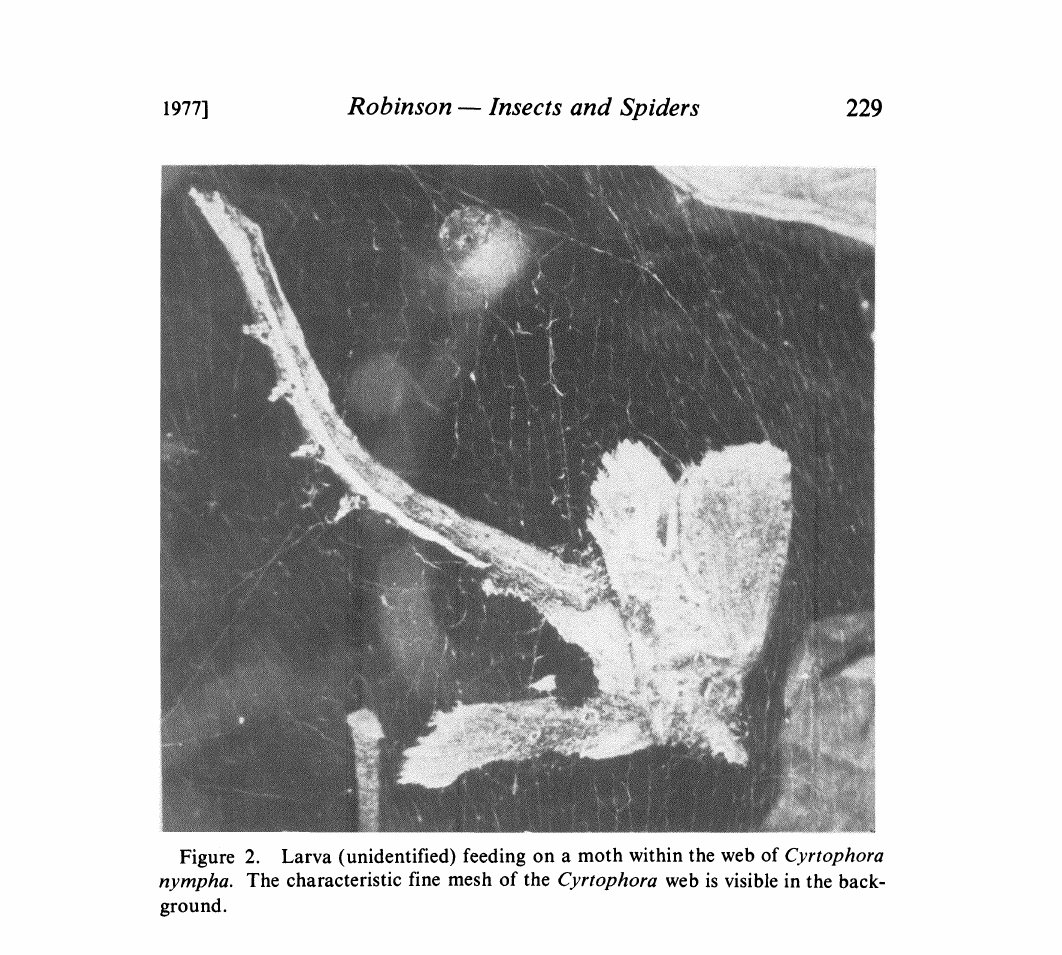
Figure 2. Larva (unidentified) feeding on a moth within the web of Cyrtophora nympha. The characteristic fine mesh of the Cyrtophora web is visible in the back-